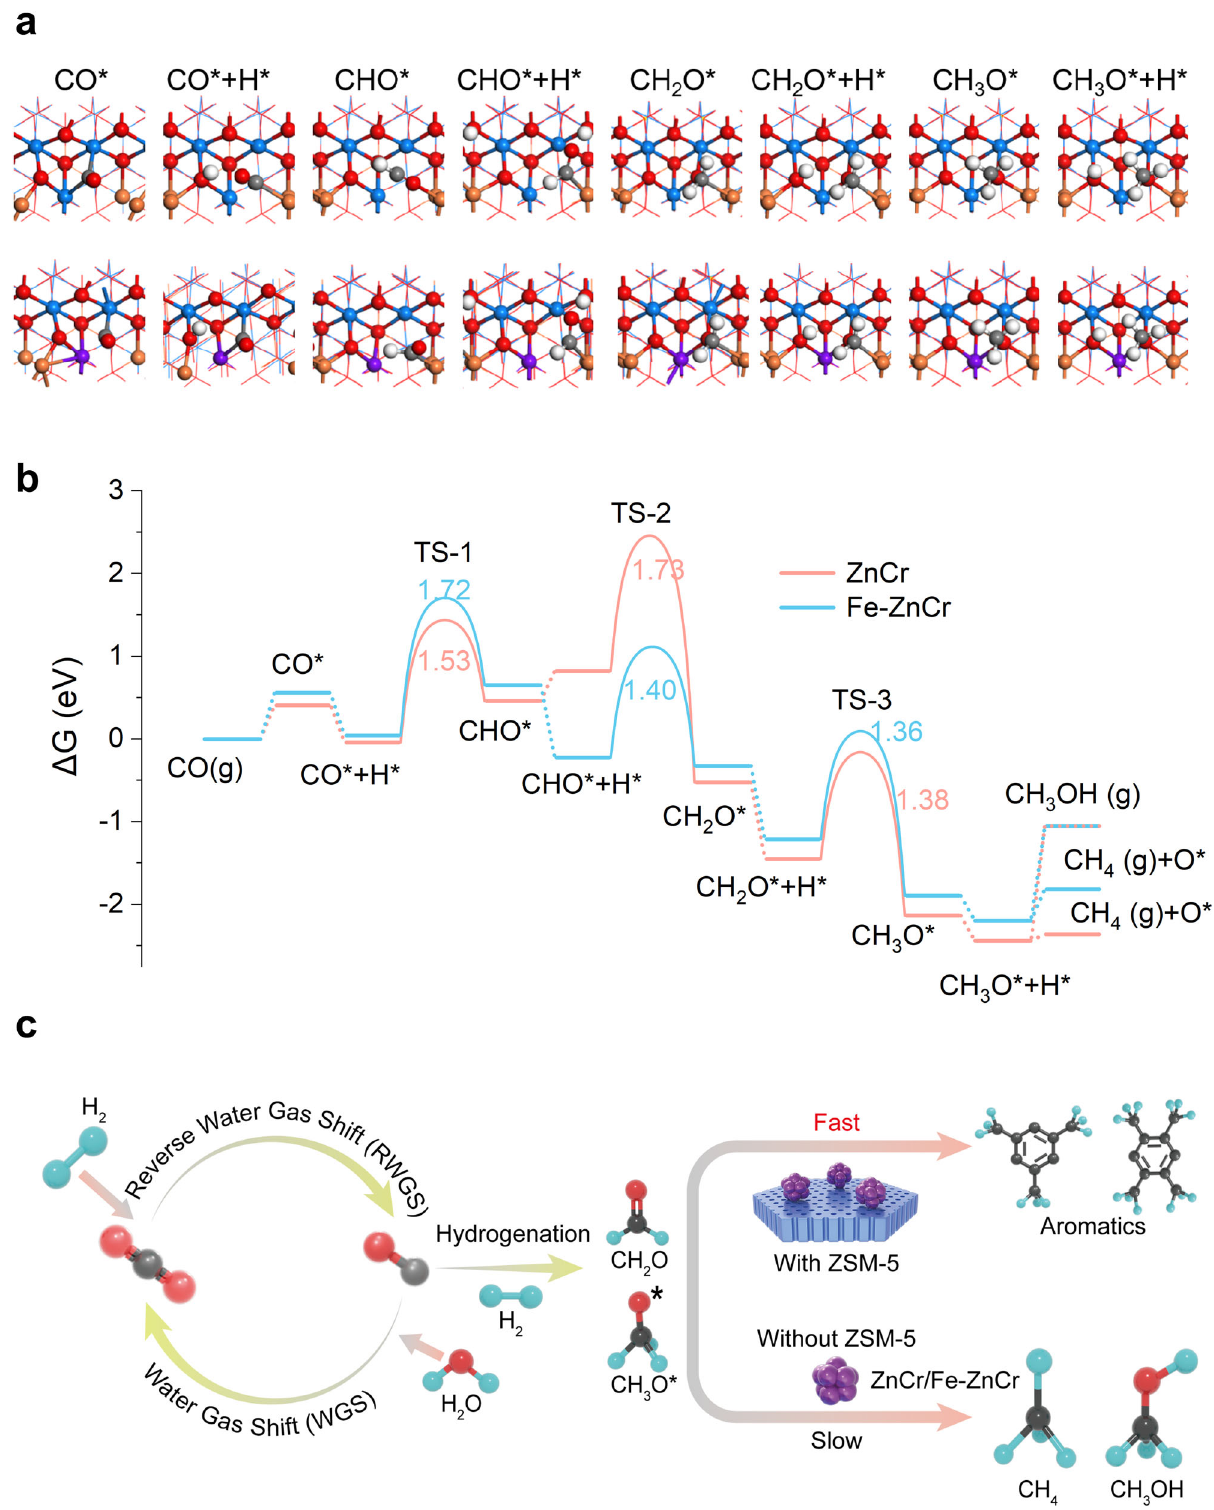
Fig. 4 | The mechanism study of monodispersed Fe and pristine ZnCr 2 O 4 in syngas conversion. a The atomic structures of the syngas conversion to CH 3 OH/ CH 4 . The reaction images are shown in the inset of a ; Zn: orange, Cr: blue, Fe: purple, O: red, C: gray, and H: white. b Gibbs free energy diagrams of syngas